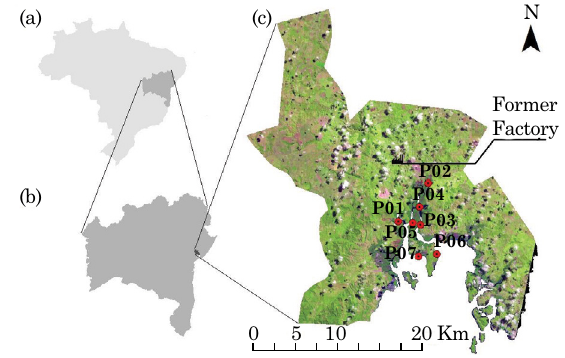
Figure 1. Location of the estuarine zone of the Subaé river, Bahia, Brazil. (a) Location of Santo Amaro, Bahia; (b) Study area in Santo Amaro; and (c) Location of the